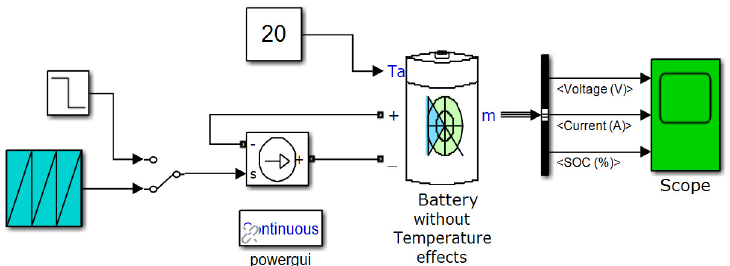
Figure 19. The Simscape model of a generic 6 Ah and 3.2 V Li-ion battery (without temperature and